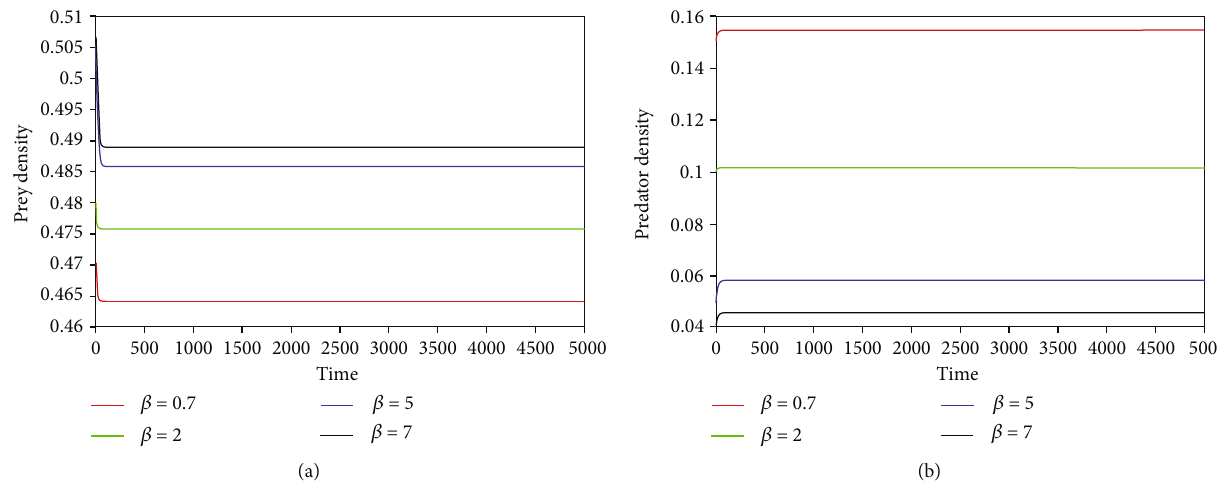
= 0 : 35, α = 0 : 5, and β = 0 : 7,2, 5, 7 and c = 0 : 1 , 1 2